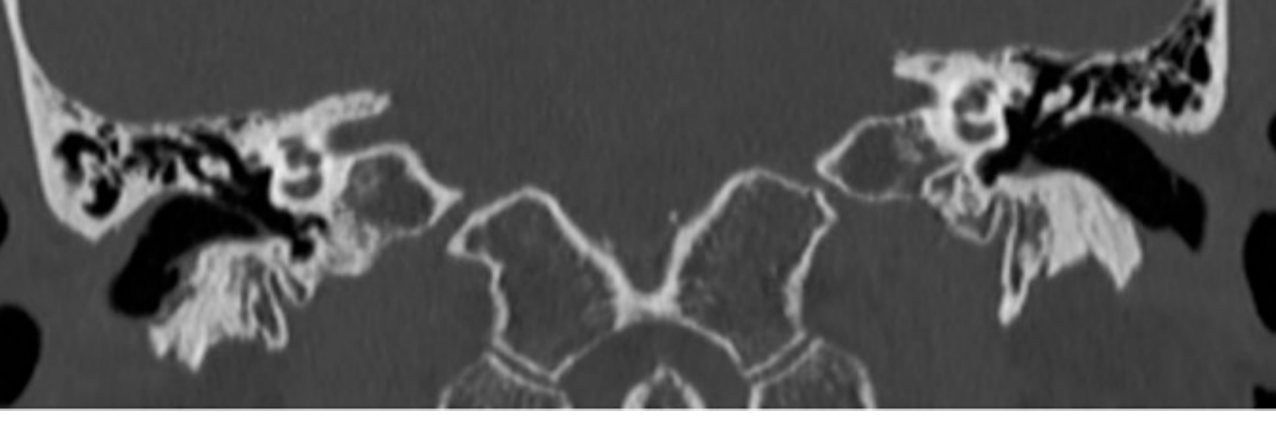
Figure 3. Patient 2, CT scan: evidence of a thin layer of soft and erosive tissue on the right inferior wall of the EAC.